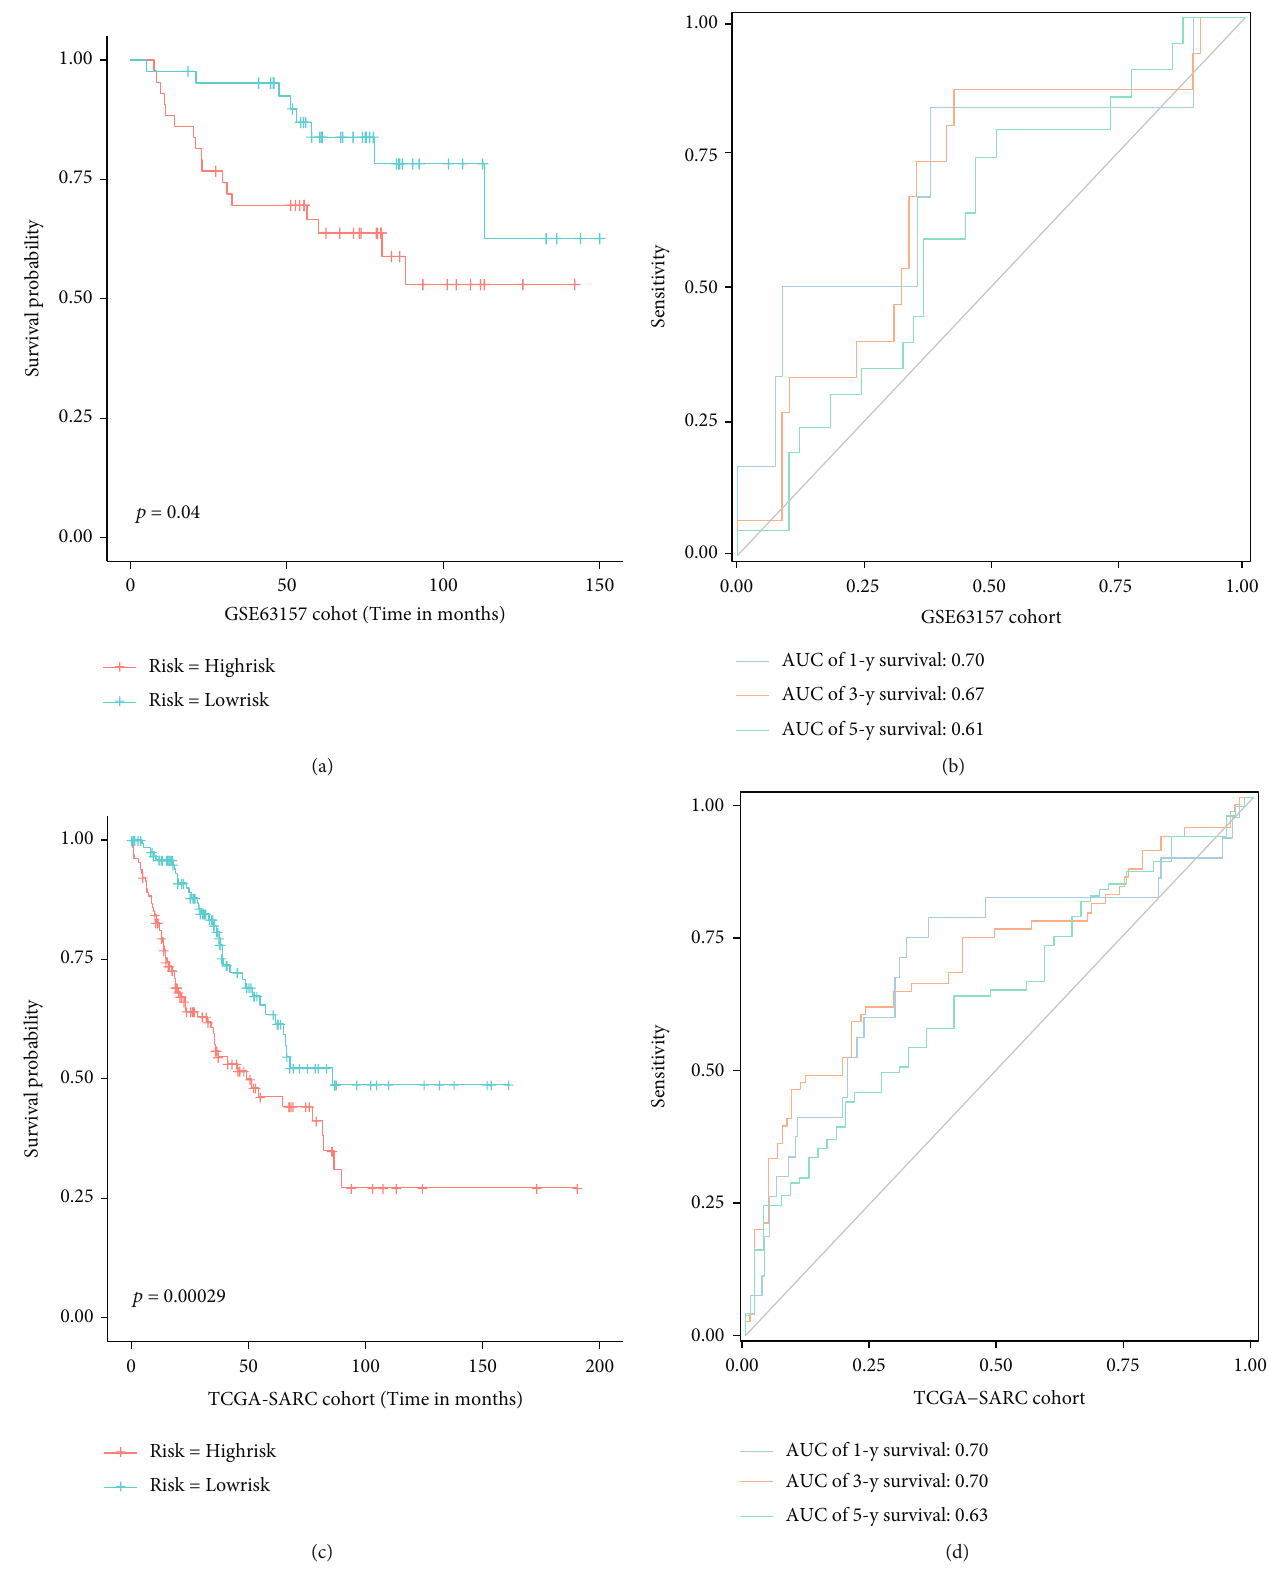
Figure 4: Evaluation of the performance of the gene signature by external validation cohorts. In the GSE63157 cohort and TCGA-SARC cohort: Kaplan-Meier curves (a, c) and ROC curves (b,